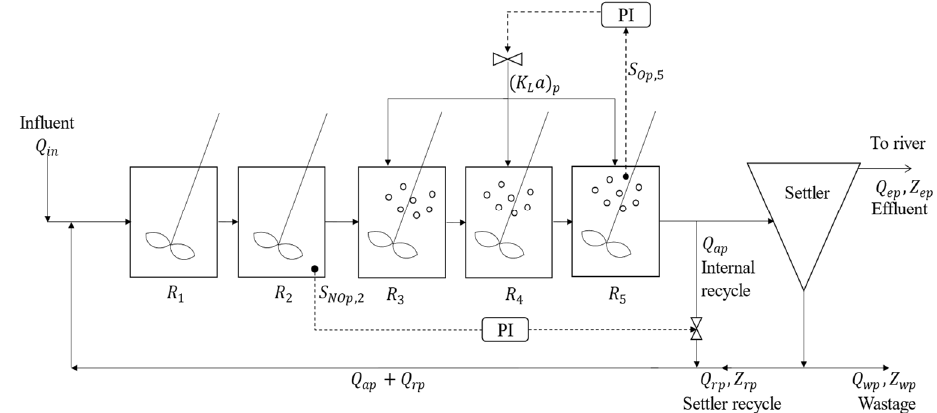
Figure 1. Schematic representation of the controlled BSM1 plant.